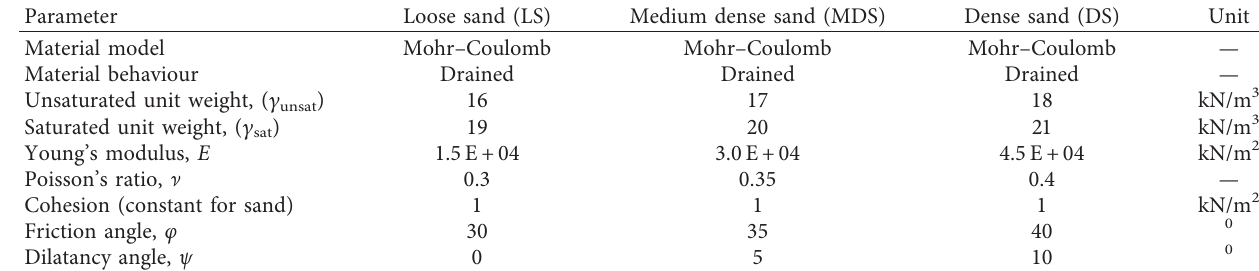
Table 1: Material properties of sand layer [25].